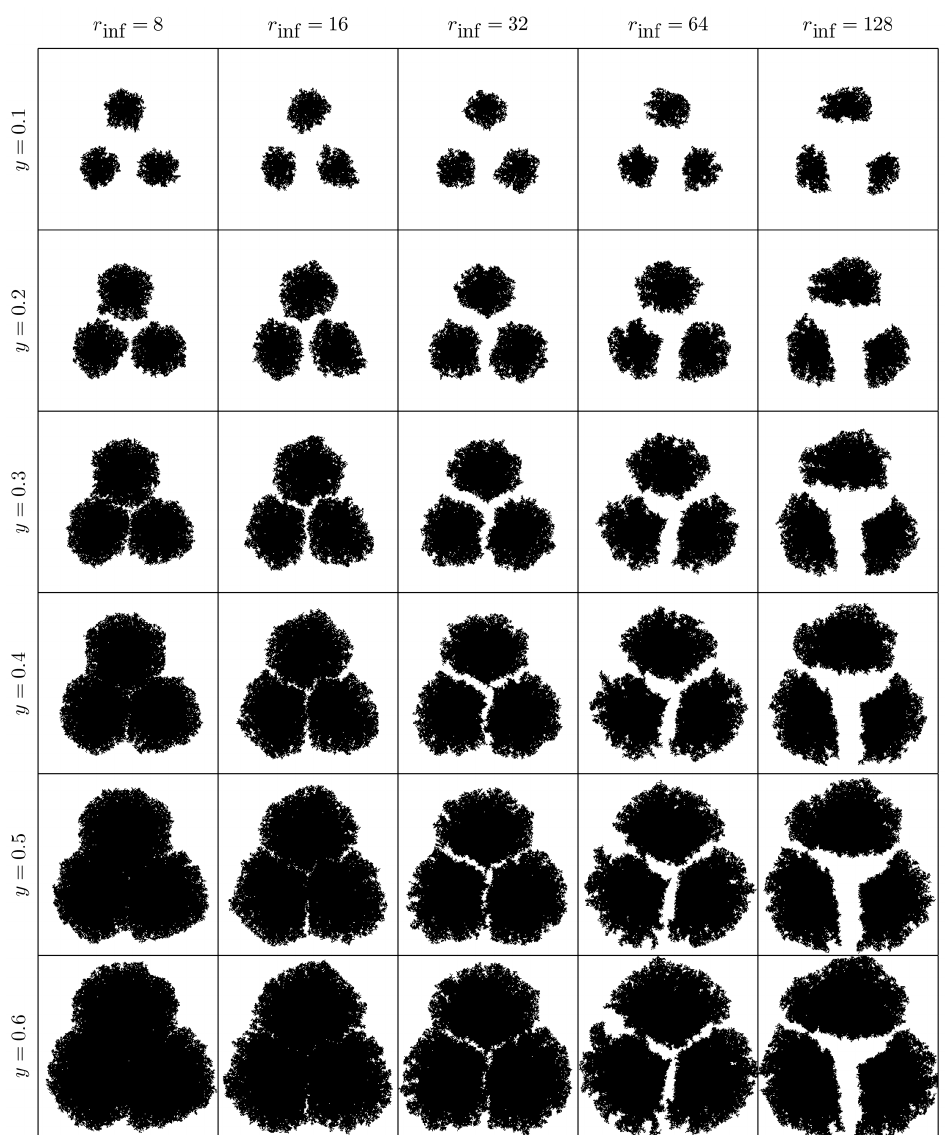
Figure 7. Evolution of 3 crystallization nuclei (for occupied area proportion from y = 0.1 to y = 0.6) with different values of r inf , taking α = 0.8, β = 1, and n = 256. The parameter r inf determines the width of the “channels”. The simulations were carried out setting C at the vertices of a regular